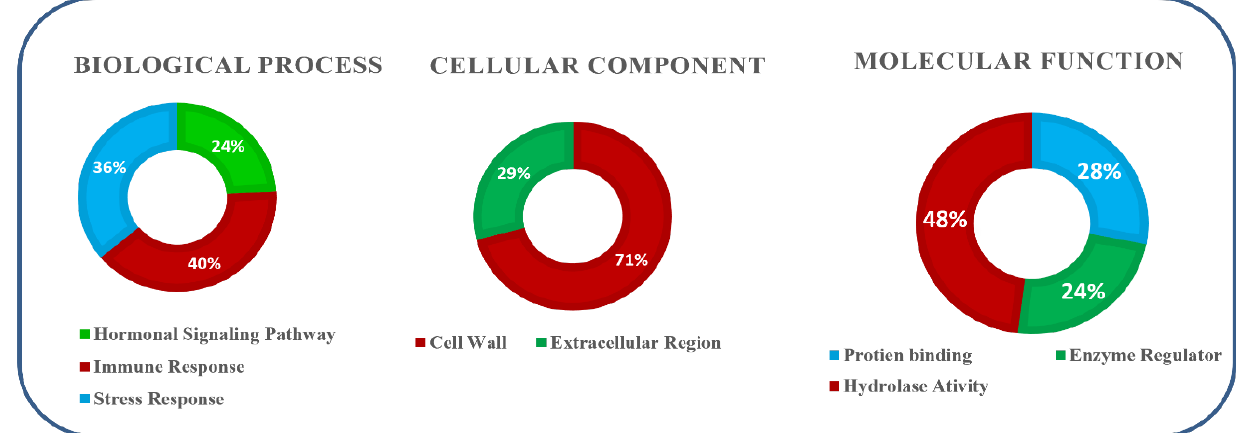
Figure 5. Gene ontology (GO) enrichment analysis of TLP genes in Oryza sativa . The data are repre- sented as biological processes, molecular processes, and cellular processes.